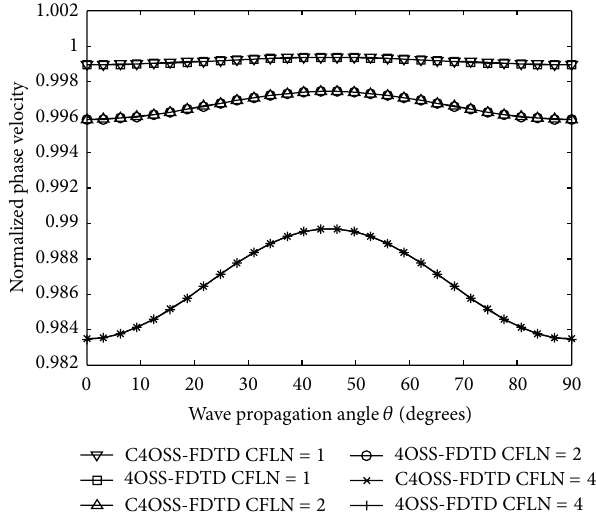
Figure 3: Normalized velocity-anisotropy error against sample density (CFLN =